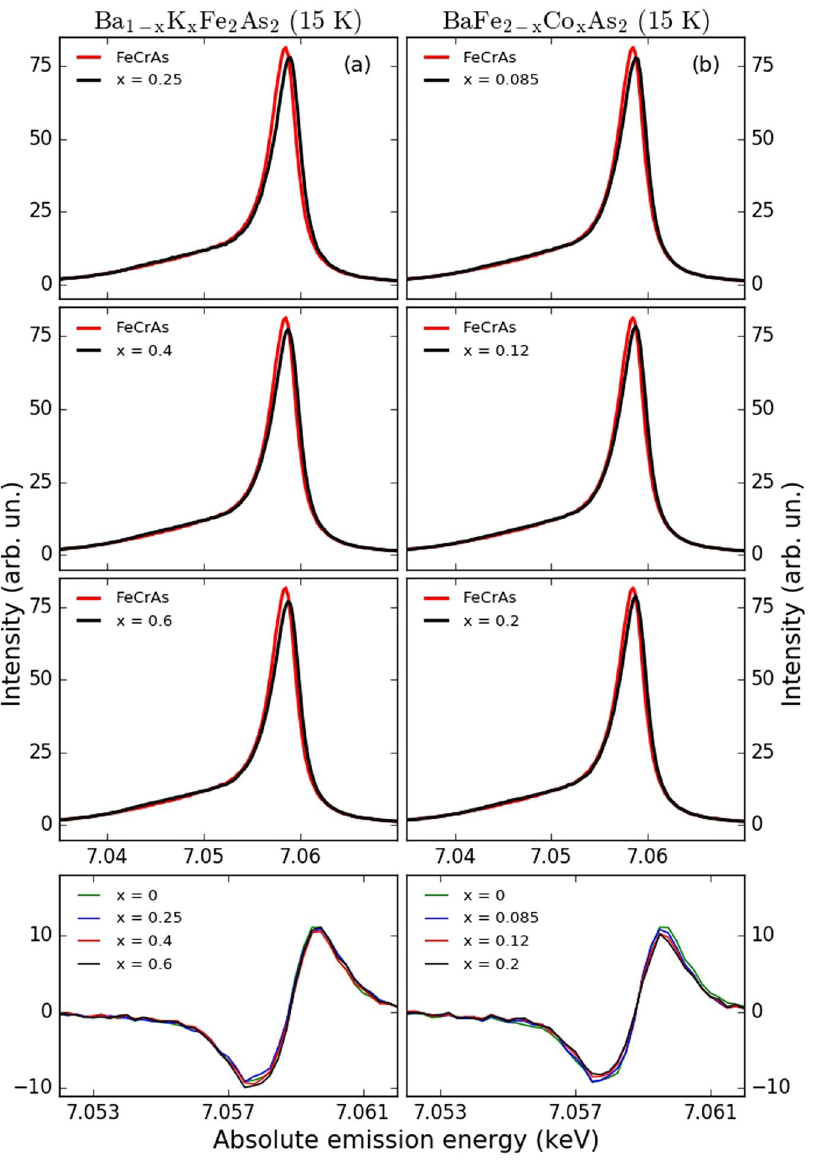
Figure 2. K β XES for Ba 1 − x K x Fe 2 As 2 ( a ) with x = 0.25, 0.4, and 0.6 and Ba 1 − x K x Fe 2 As 2 ( b ) with x = 0.085, 0.12, and 0.2 at 15 K. The last row is indicating the relative difference spectra for Ba 1 − x K x Fe 2 As 2 and Ba 1 − x K x Fe 2 As 2